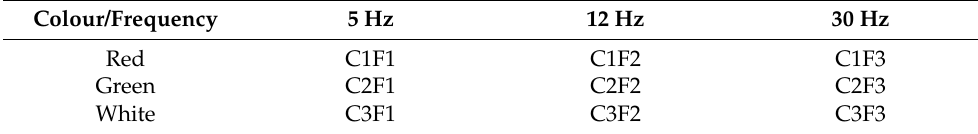
Figure 2. Square stimuli with the three colors presented during the experiment. Table 1. Experimental conditions resulting from combining stimulus color and